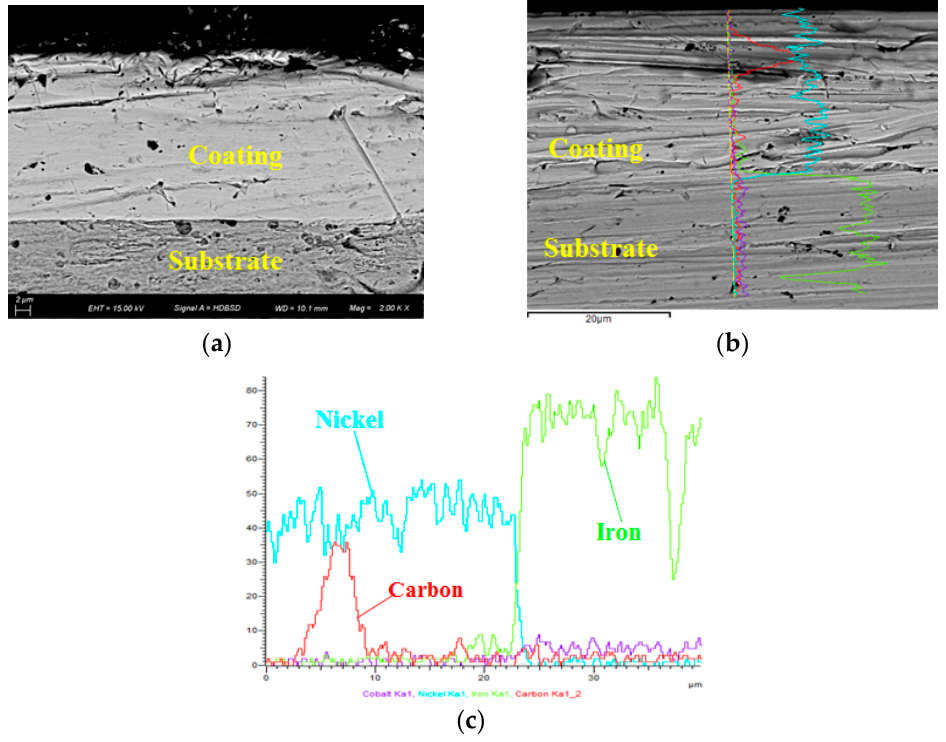
Figure 2. Cross-sectional image of the plating: ( a ) chemically etched cross section, ( b ) cross section before chemical etching and ( c ) analysis of cross-sectional elements at different depths.